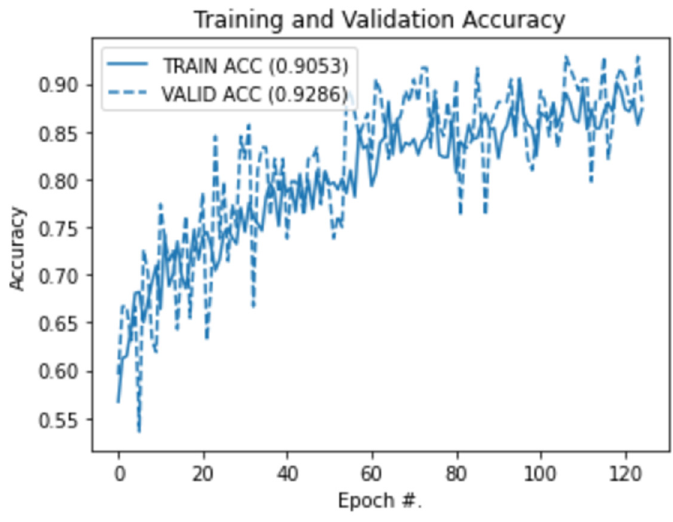
Figure 12. Training and Validation Performance.